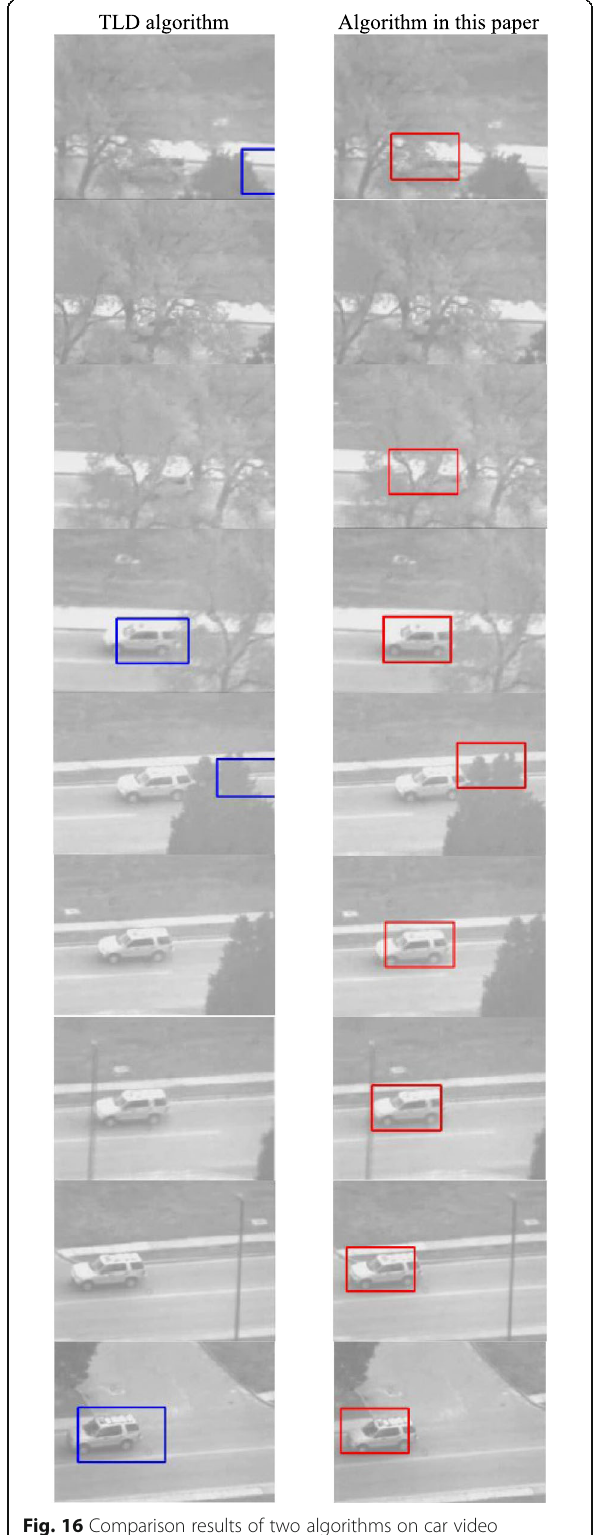
Fig. 16 Comparison results of two algorithms on car